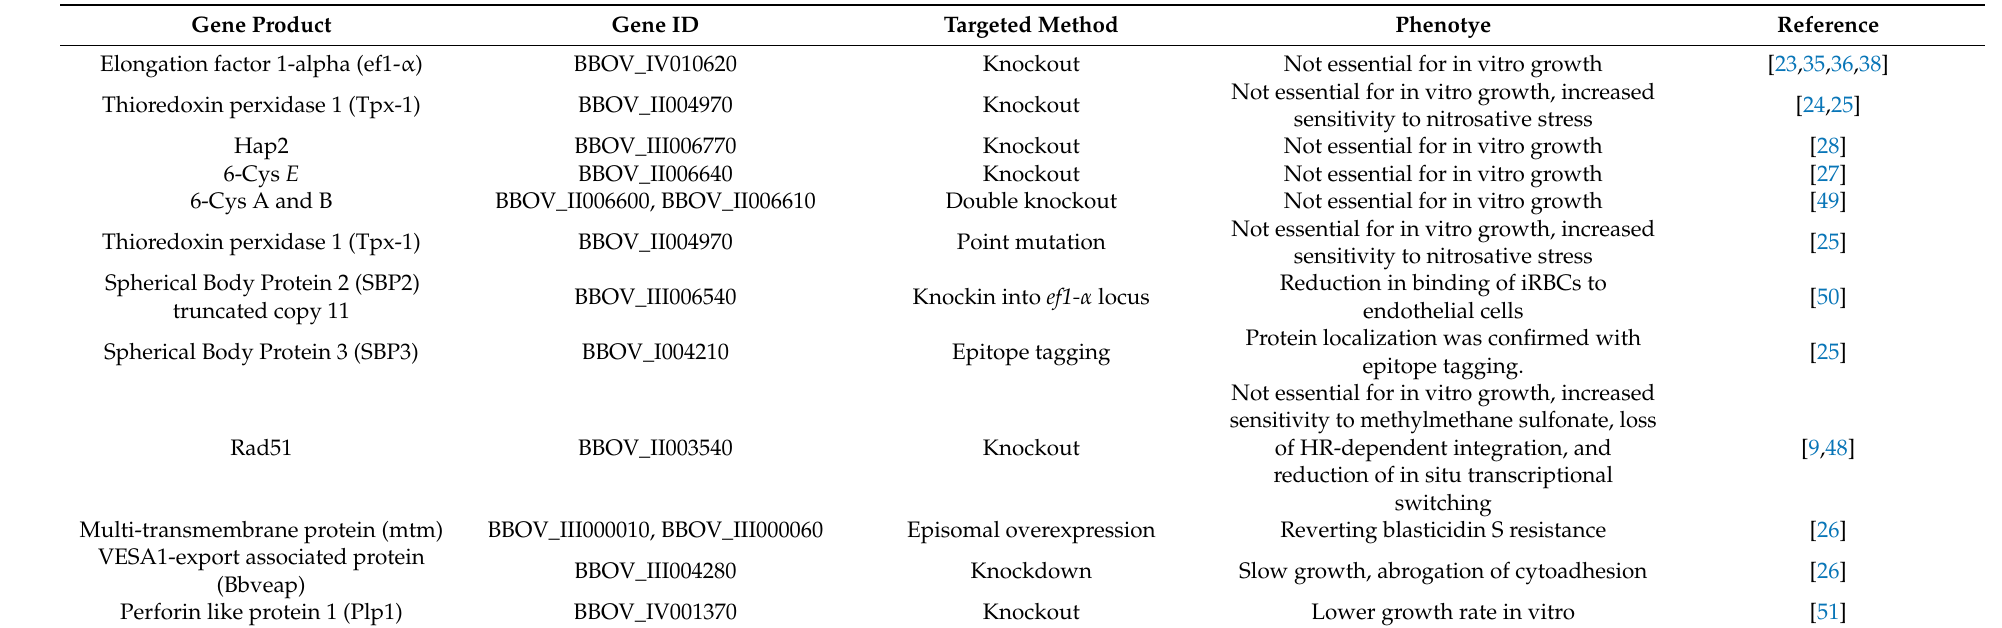
Table 1. List of B. bovis genes targeted for gene disruption, tagging, or